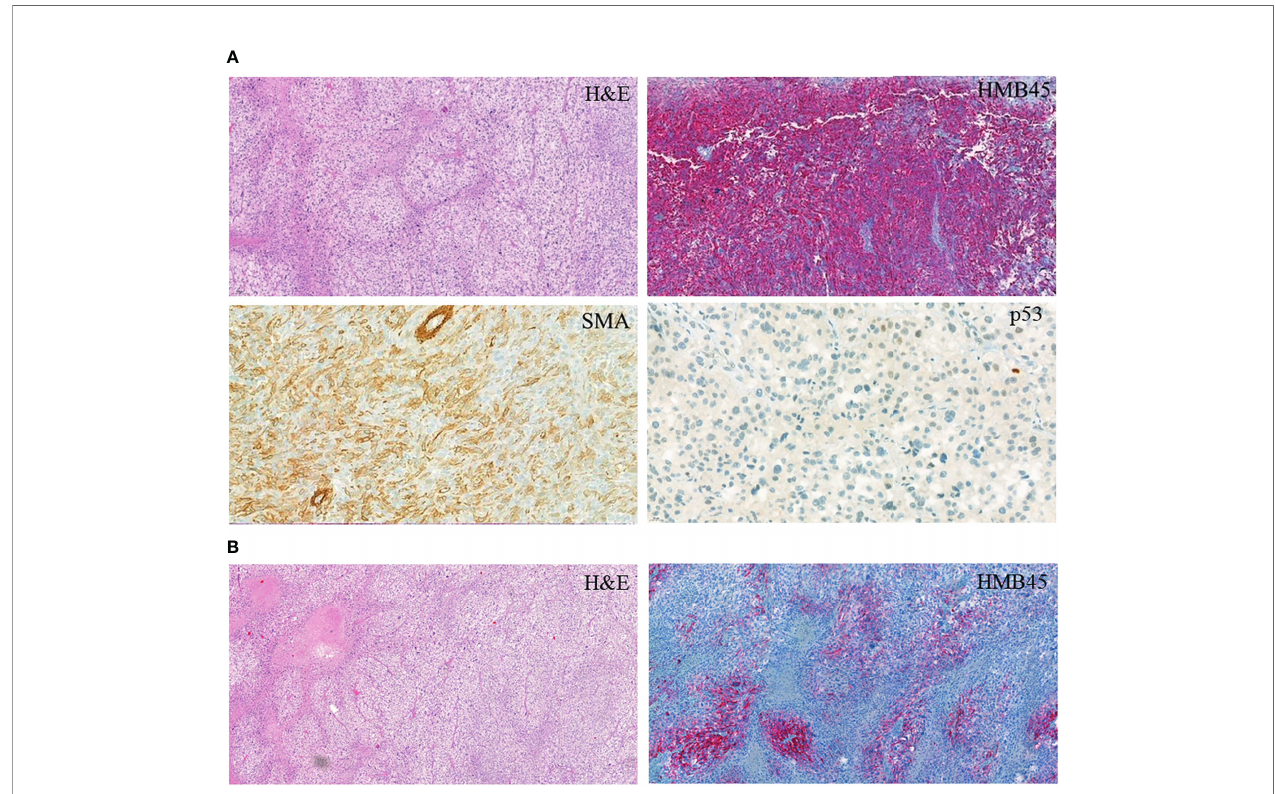
FIGURE 1 | Immunohistochemistry of the PEComa tissue. (A) PEComa metastasis in the lung. (B) Primary